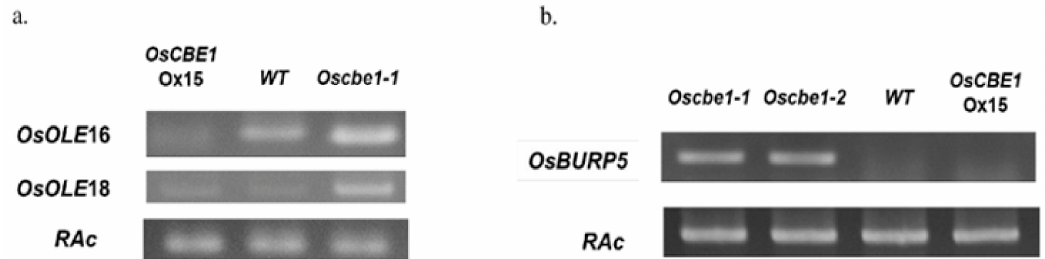
Figure 6. Regulation of OsOLE16 , OsOLE18, and OsBURP5 in OsCBE1 lines. ( a ) Expression of OsOLE16 and OsOLE18 in OsCBE1 lines are presented. OsOLE16 and OsOLE18 are up-regulated in KO line. OsOLE16 are down-regulated in the overexpression line. ( b ) Expression of OsBURP5 in OsCBE1 lines are presented. OsBURP5 is upregulated in KO